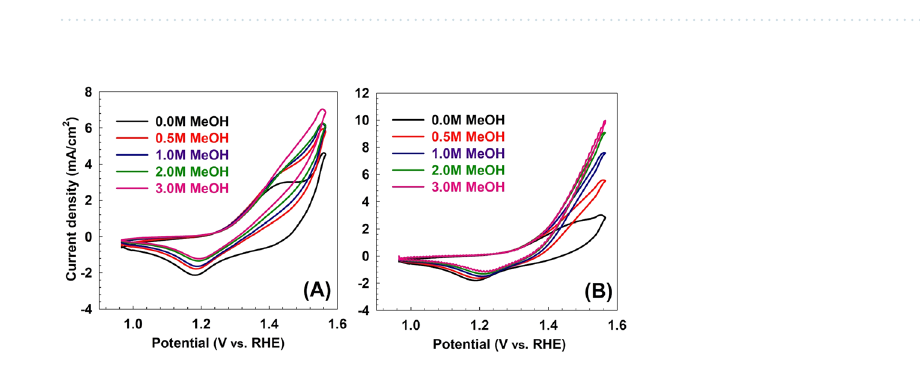
Figure 9. Cyclic voltammetry of samples calcined at 600 °C ( A ) before and ( B ) after MO adsorption for different methanol oxidation at 50 mV/s scan